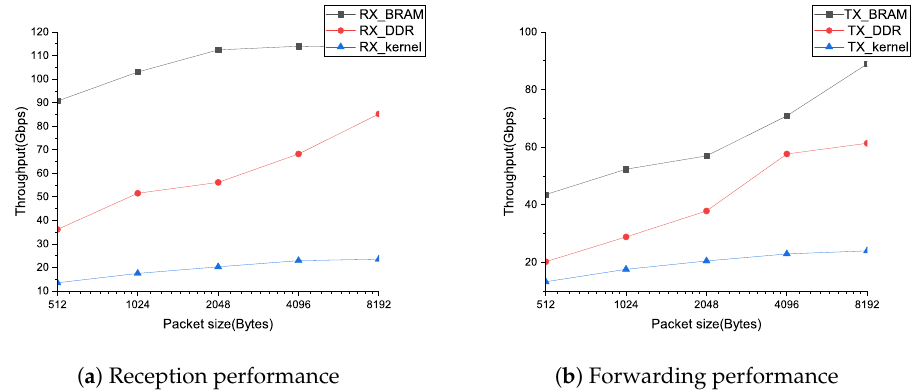
Figure 7. Transmission performance diagram.